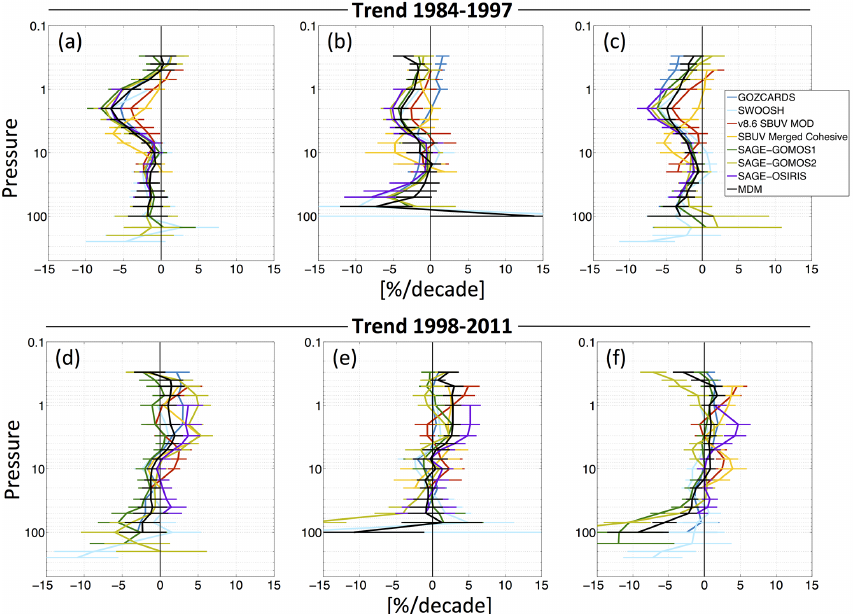
Figure 8. Latitudinal average ozone profile trends (in %decade − 1 ) for 1984–1997 (top row) and 1998–2011 (bottom row). Left column ( a and d ): Southern Hemisphere mid-latitudes (35–60 ◦ S); middle column: ( b and e ) tropics (20 ◦ N–20 ◦ S); right column: ( c and f ) Northern Hemisphere mid-latitudes (35–60 ◦ N). The horizontal error bars indicate ± 2 σ